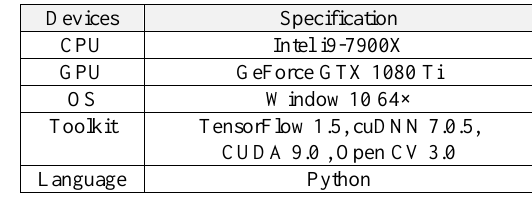
Table 1. System configurations for the experiment.